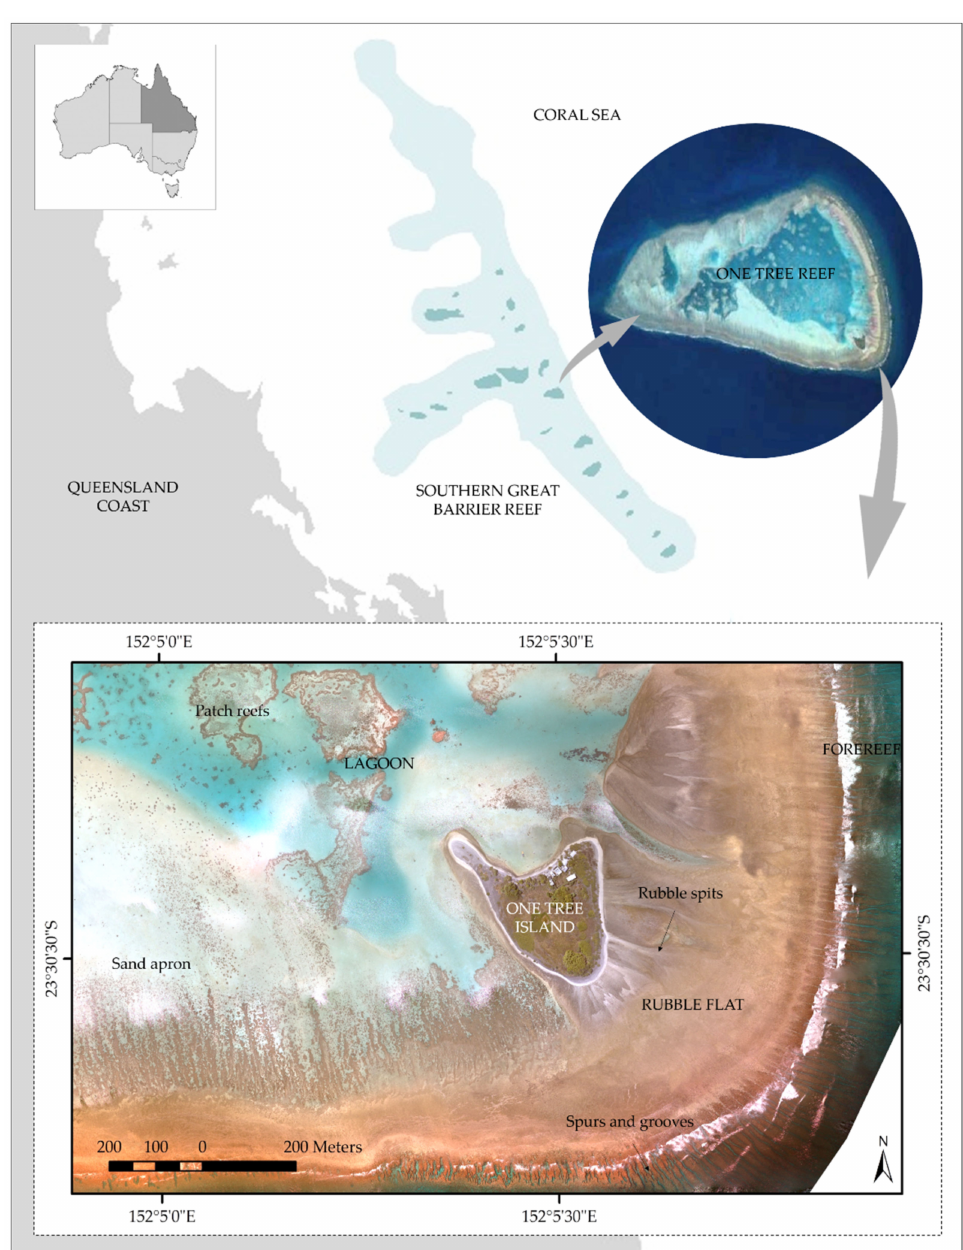
Figure 1. Location map of the southern Great Barrier Reef and One Tree Island. The dominant winds in this region come from the southeast, and it is strong between December and April when associated with the passage of cyclones. Waves at One Tree Reef are characterized by average significant wave height ( H s ) of 1.54 m, peak wave period ( T p ) of 7.43 s, and a mean wave direction ( Ө m ) of around 115–120 ◦ (lagoon-ward), corresponding to a mean wave power ( P ) of 20.93 N m − 1 . Tides are semidiurnal and mesotidal, with an average spring tidal range of 3 m